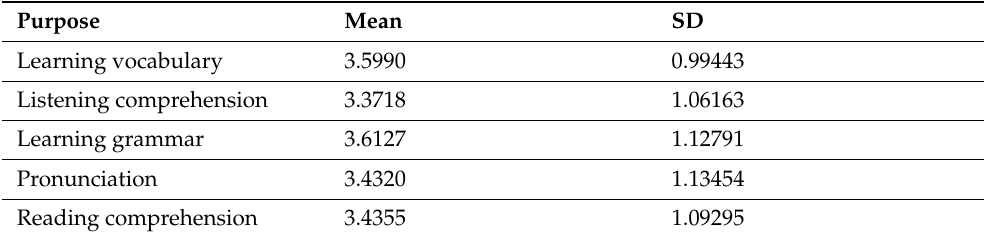
Table 3. Purpose of using